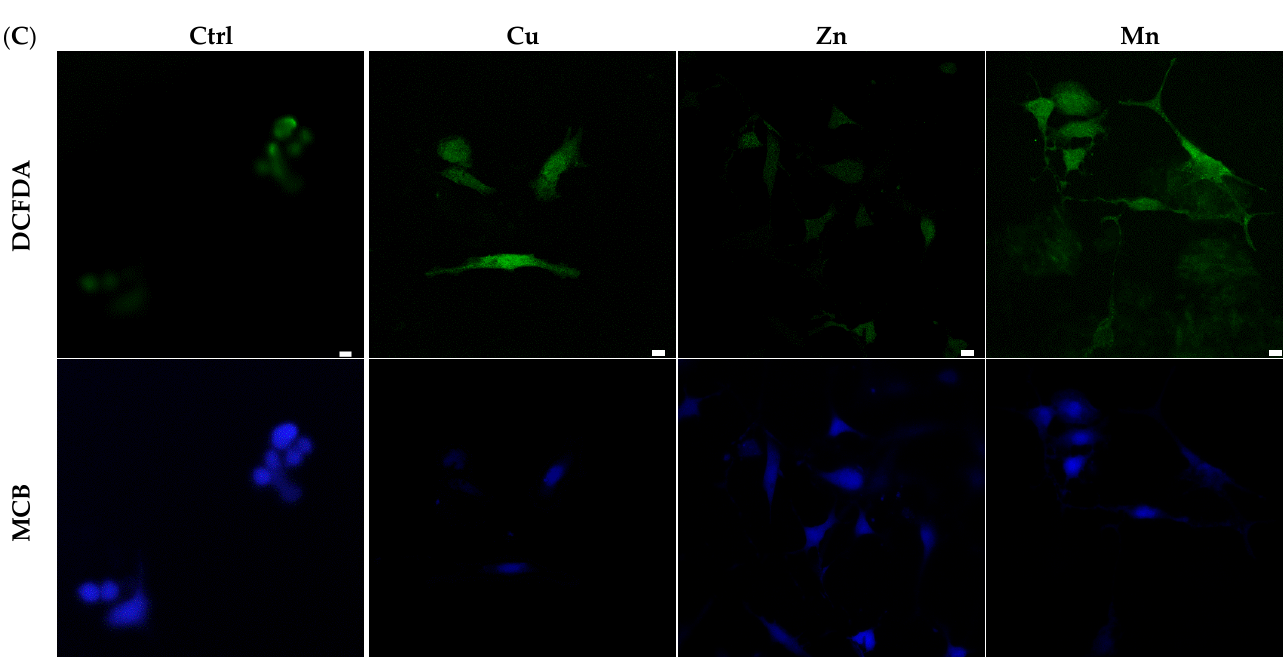
Figure 7. ( A ) Extracellular generation of ROS in the reaction of TM-modified PA matrices with H 2 O 2 according to DCFDA fluorescence (λex/λem = 490/526 nm). ( B ) Intracellular levels of ROS and GSH in PC-12 grown on TM-modified PA matrices (metal concentration was 10 µ M) at 24 h post-seeding (* p < 0.05). The levels of GSH were determined according to monochlorobimane (MCB) fluorescence ( λ ex/ λ em = 380/480). ( C ) LSCM of TM-modified PA matrices with live cells co-stained with DCFDA/MCB. Argon (488 nm) and diode (405 nm) lasers were used for dual excitation of DCFDA and MCB, respectively. Scale bar 20 µm.